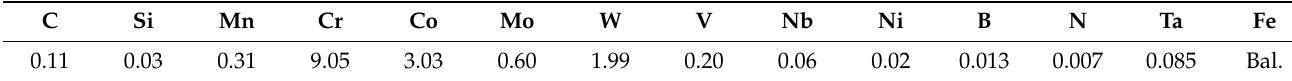
Table 1. Chemical composition of the studied steel